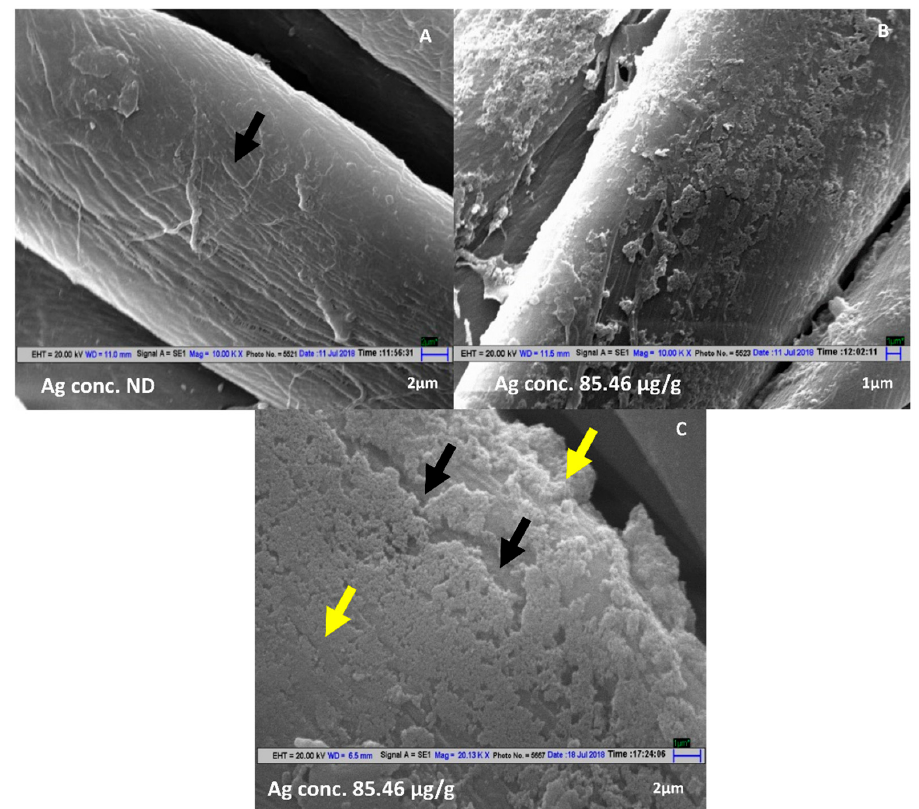
Figure 1. SEM micrographs of mercerized fabrics: ( A ) No AgNP treatment. ( B ) A 2 mM AgNO 3 , 20% Leaf Extract, Mixing ratio 9:1, pH 7.1, hydrothermal conditions (Magnification 10KX). ( C ) A 2 mM AgNO 3 , 20% Leaf Extract, Mixing ratio 9:1, pH 7.1, hydrothermal conditions (Magnification 20 KX). Black arrows indicate the cotton fiber and yellow arrows indicate AgNP deposition the on fiber. ND represents Not Detected.